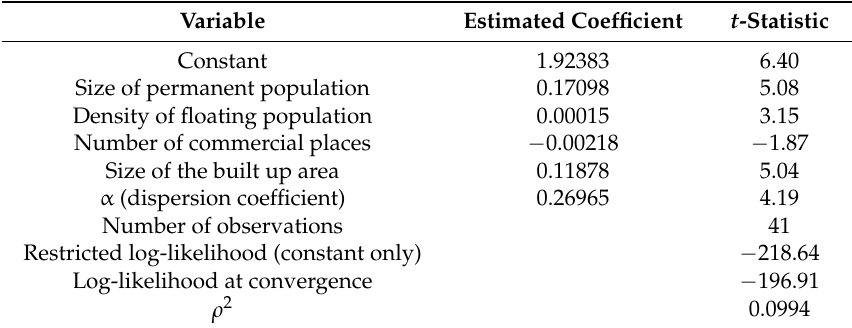
Table 2. Negative binomial estimation results of motor vehicle